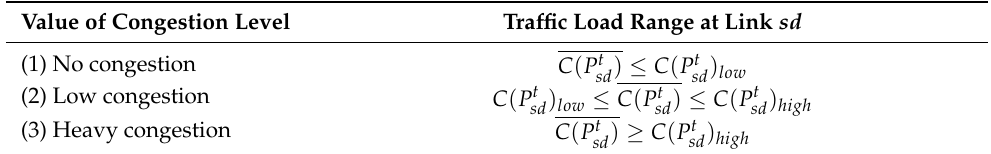
Table 2. Link load and congestion level mapping.